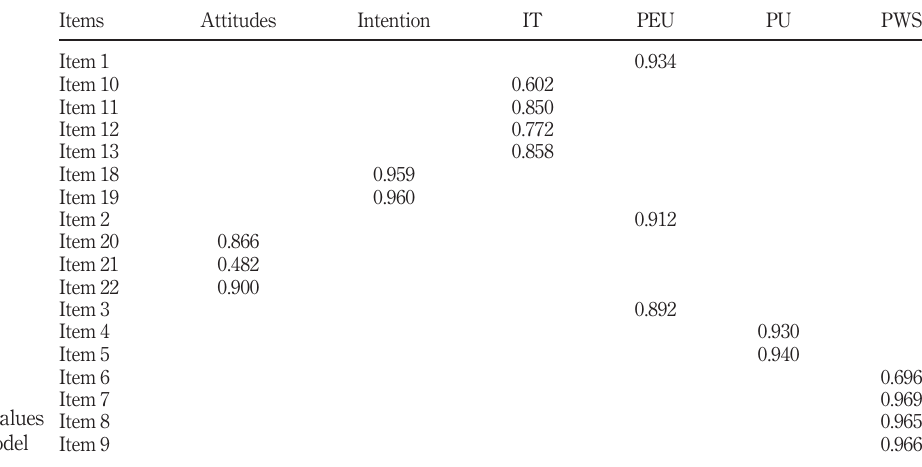
Table 4. Factor loading